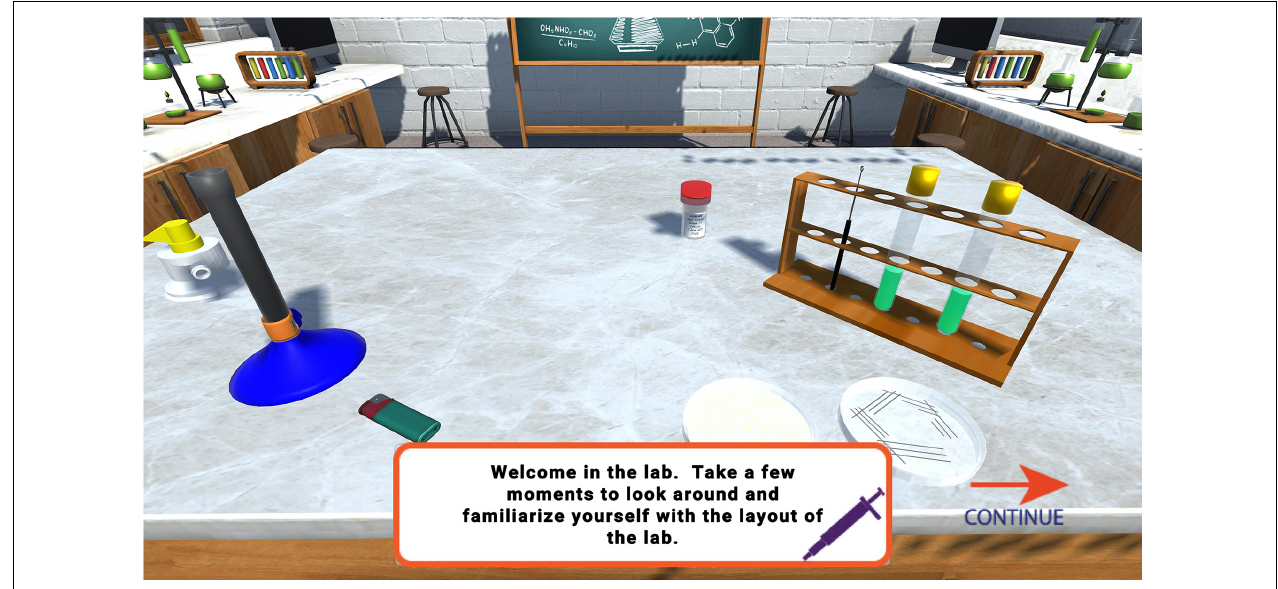
FIGURE 2 | 3D Models placed in Unity3D. Several 3D models were generated in Blender, including the Bunsen burner, Petri dishes with agar, inoculation loop, green fluid test tubes, and the gas